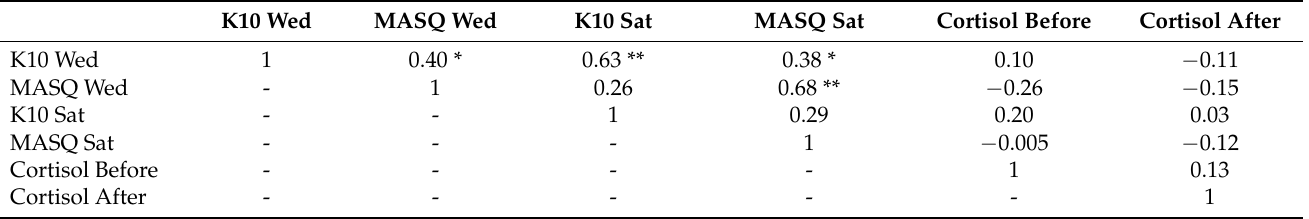
Table 4. Pearson’s correlation coefficient test results for K10 and MASQ scores on Wednesday and Saturday and saliva cortisol levels before and after exercise.